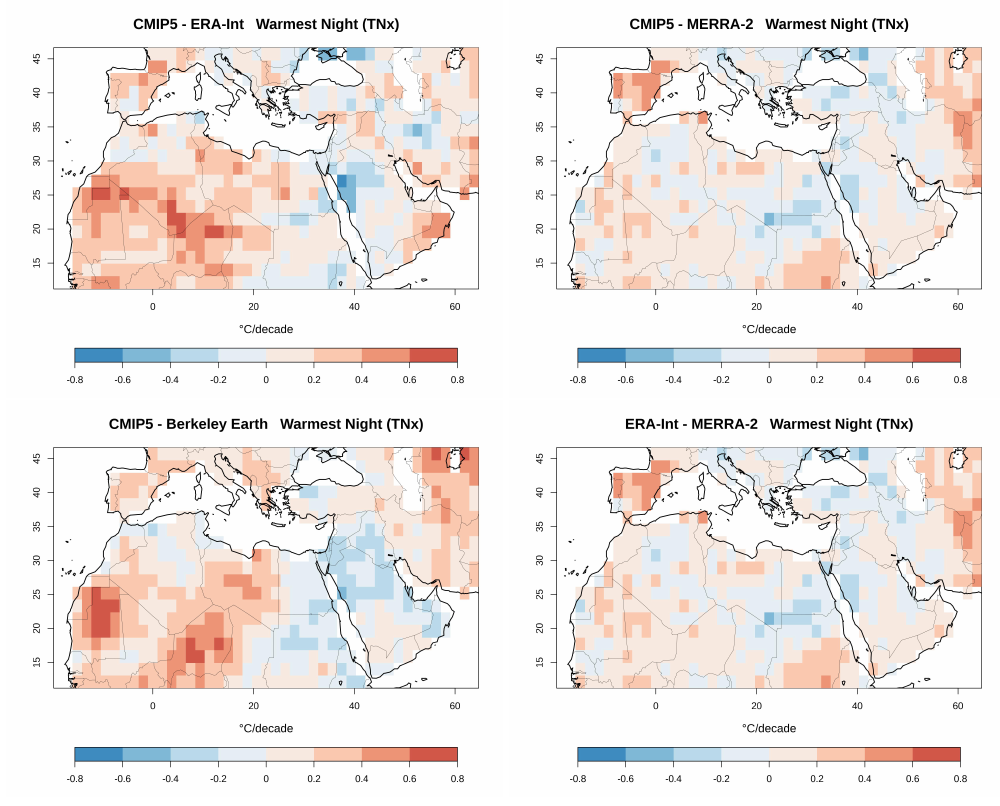
Figure A6. Same as Figure A5 but for the Warmest Night (TNx).